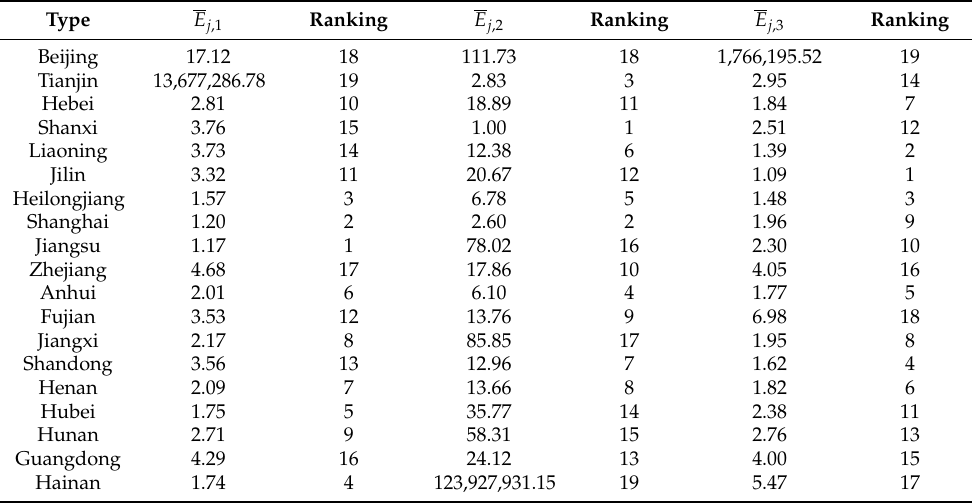
Table 5. Efficiency values of three subsystems in the first stage.